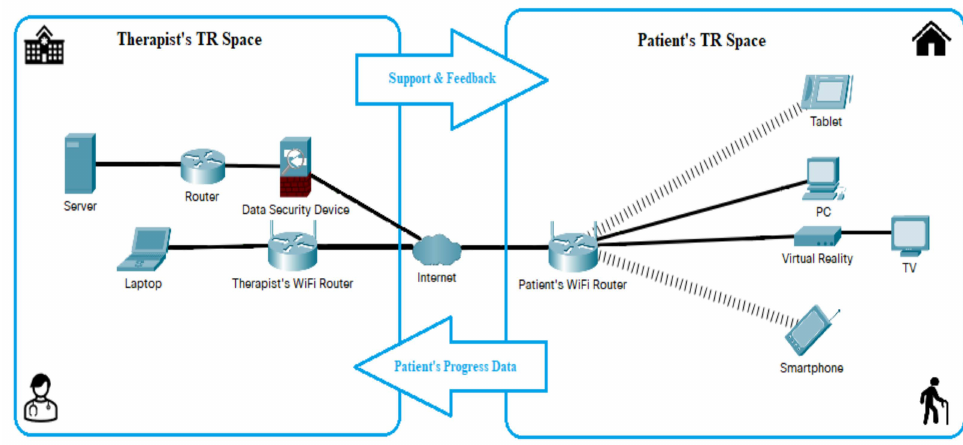
Figure 4. TR network